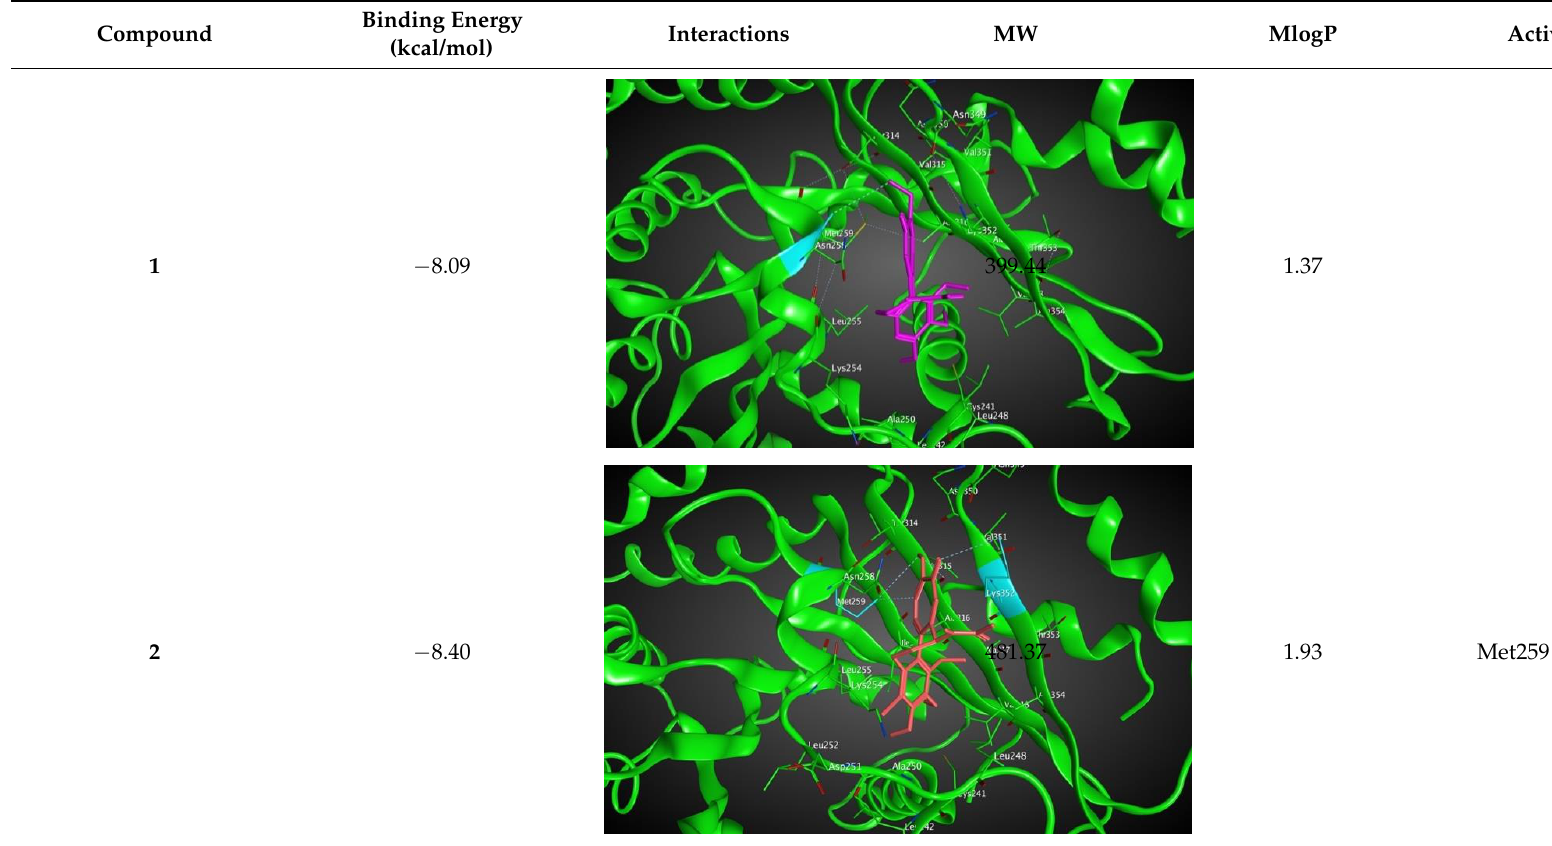
Table 2. Calculated binding energies for the interactions between the new colchicine derivatives investigated in this paper and β I tubulin, and also the values of the Moriguchi octanol-water partition coefficient, MlogP, calculated for the same colchicine derivatives.